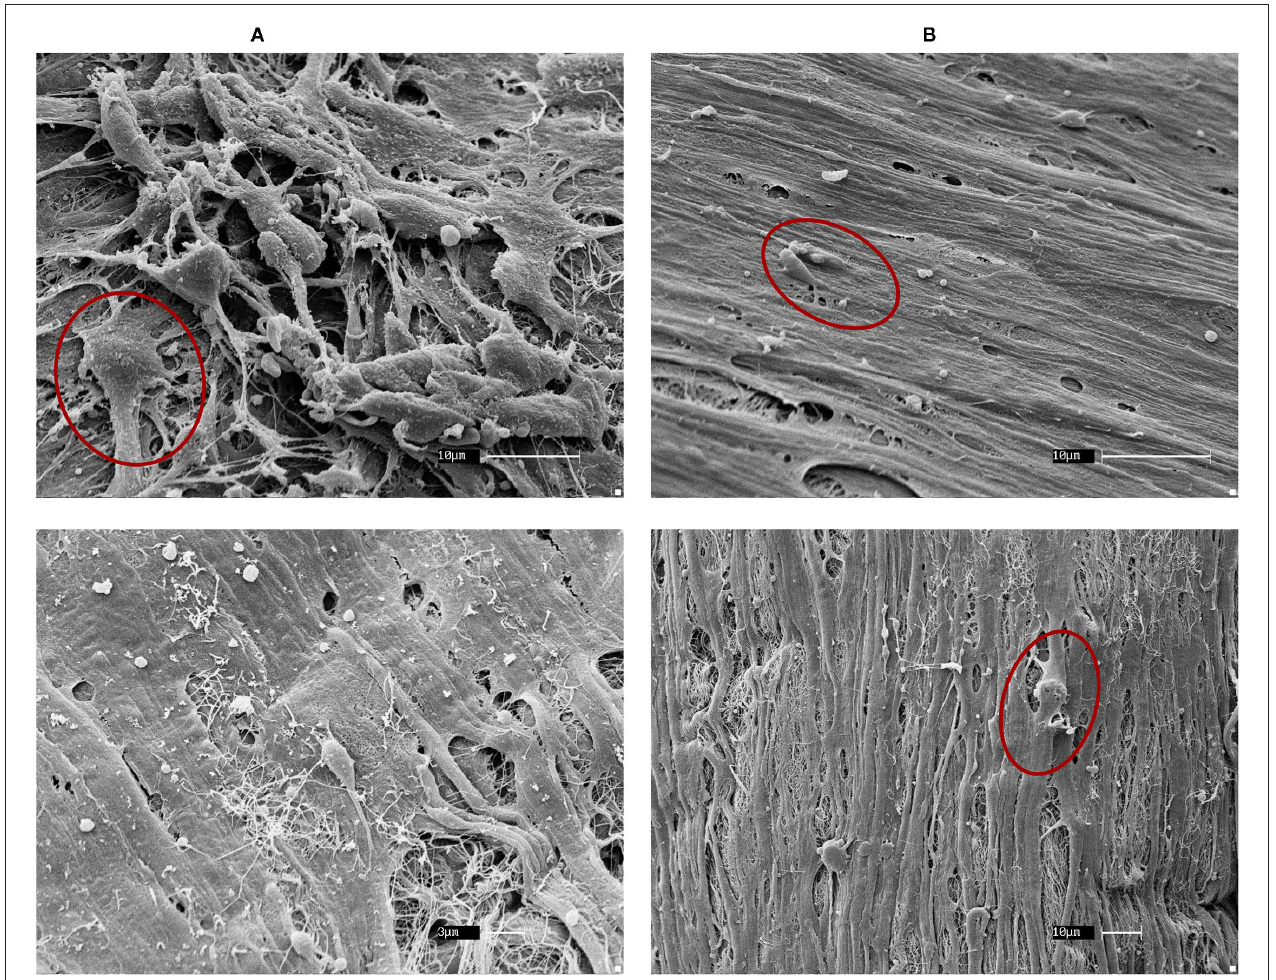
FIGURE 4 | SEM of horse embryonic fibroblast recellularization. Fibroblasts had a good coverage of the matrices and an even distribution in both (A) control and (B) asthmatic matrices. Red circles show example of fibroblasts. Magnifications are specified on each